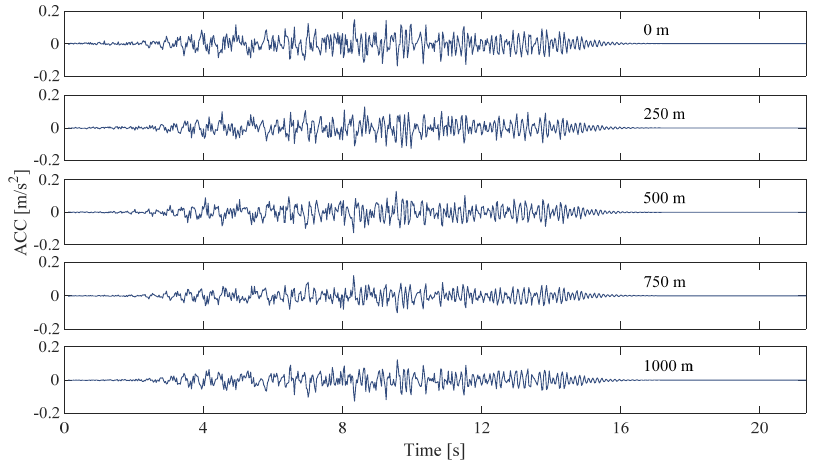
Figure 28. Changes in seismic waves at different distance.